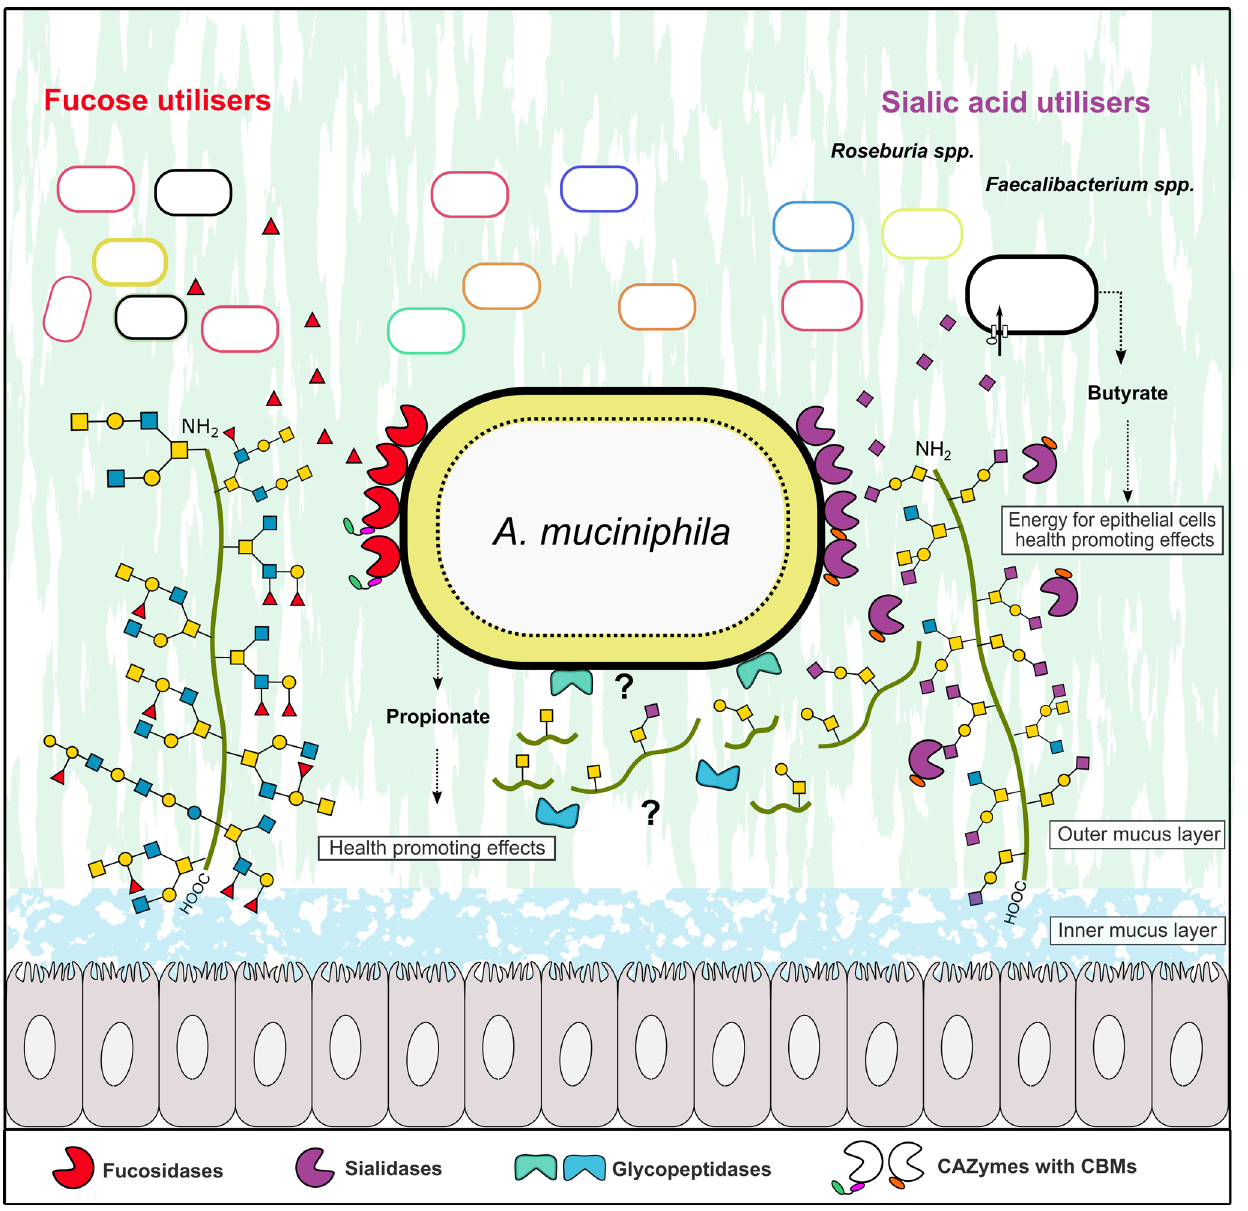
Fig.5|Modelformucindefucosylationanddesialylationby A.muciniphila and sharing of fucose and sialic acid with mucus adherent butyrogenic gut microbiota. The Grey cells represent epithelial colonocytes, and the green line represents the mucin peptide backbone. The fucosidase activity was detected mainly in the intact A. muciniphila cell fraction, which is consistent with an extra- cellular cell-attached localization. Sialidase activity on 3´-sialyllactose and 6´-sia- lyllactose was detected both in intact cells and culture supernatant, which is consistentwiththecellattachmentofatleastonesialidaseandsecretionofatleast one sialidase. The removal of sialic acid exposes the recognition motifs